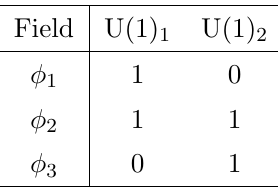
Table 1 . An example of squashed A 1 with (cid:13)avor charges of chiral